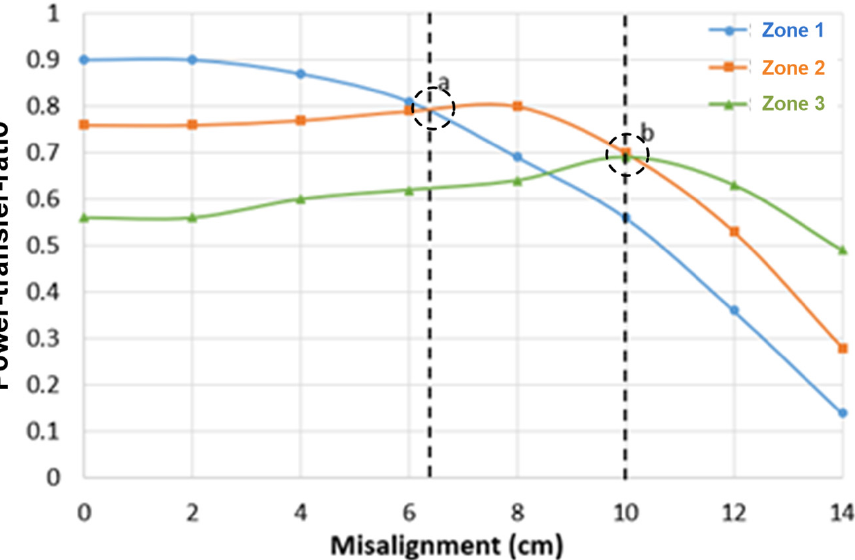
Figure 14. Measured power-transfer-ratio from the transmitter coil to the receiver coil versus mis- alignment in three operating zones.